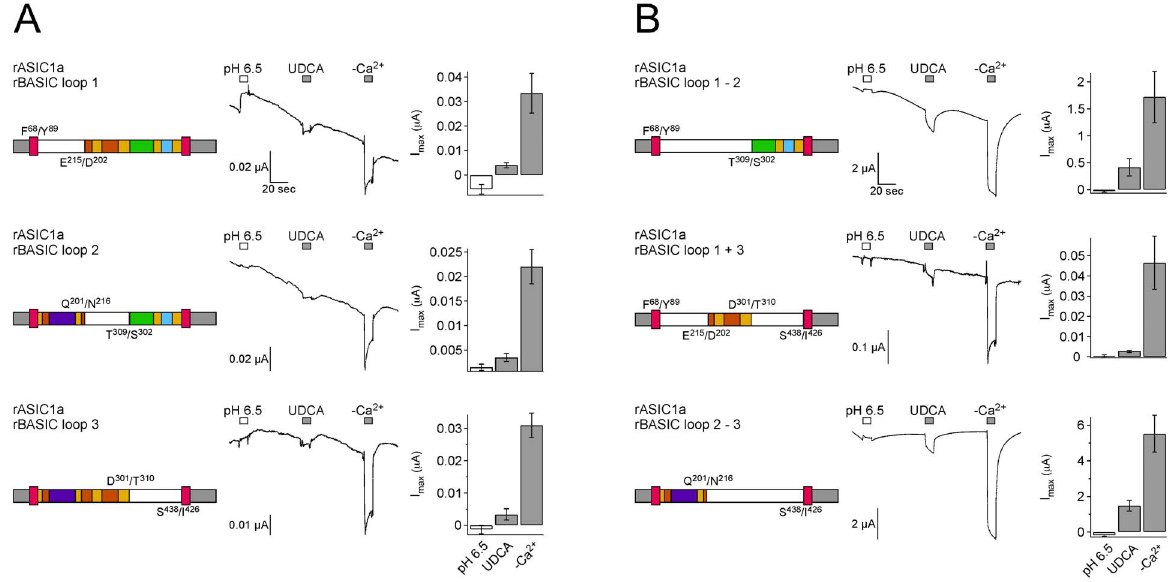
Figure 9. Several regions of the ECD of rBASIC are involved in bile acid sensitivity. A, B) Left panel, schematic drawings of chimeras; rASIC1a portions are depicted as in Fig. 5A, rBASIC portions are depicted in white. Residues defining the borders of the ASIC1a and BASIC sequences are shown. Middle panel, representative traces of currents induced by the subsequent application of pH 6.5 and 2 mM UDCA followed by the removal of divalent cations (–Ca 2 + ). Right panel, quantitative comparison of current amplitudes induced by pH 6.5, UDCA and divalents removal. Error bars represent SEM; n =6–12.